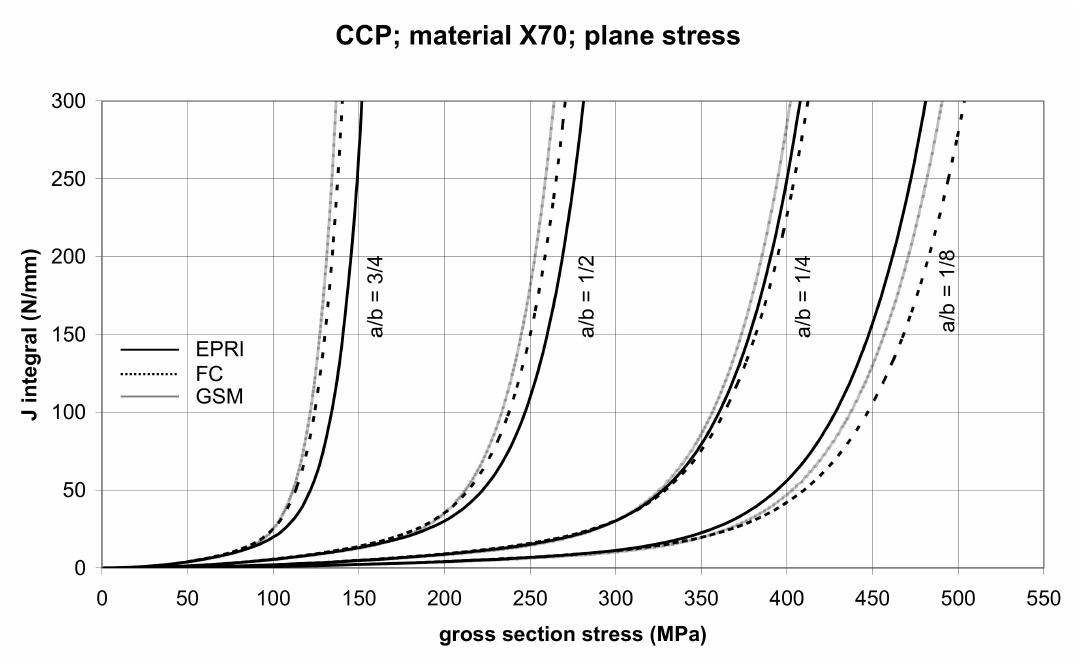
Figure 8. Comparison of J integral for CCP X70 steel specimens in the plane stress condition as determined by the EPRI, GSM, and FC methods.